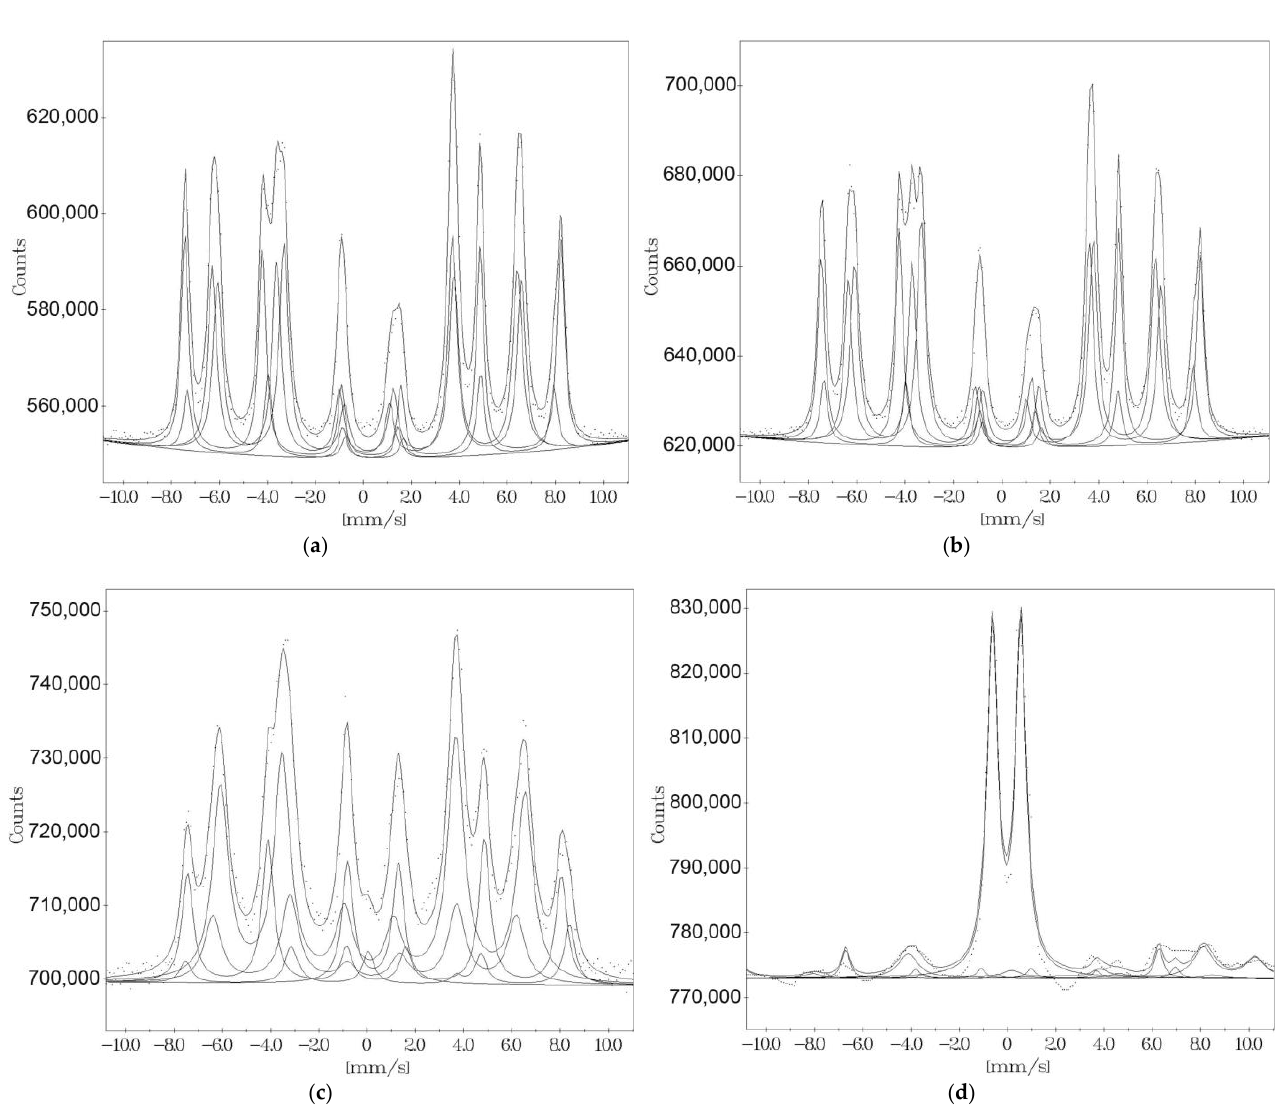
Figure 5. Conversion electron Mössbauer spectra (dots- experimental, solid lines- a1, a2, d1, d2 and doublet components) of Ne + -implanted YIG film ( E = 82 keV) with doses of 0 cm − 2 , 1 × 10 14 cm − 2 , 2 × 10 14 cm − 2 and 4 × 10 14 cm − 2 ( a – d , respectively). The amplitude, isomer shift δ , magnetic field H ef , the value of the axial components U zz of the EFG, and polar angle β between H ef and U zz were used as fitting parameters (Table 2). The calculation was carried out for samples D0, D1 and D2.